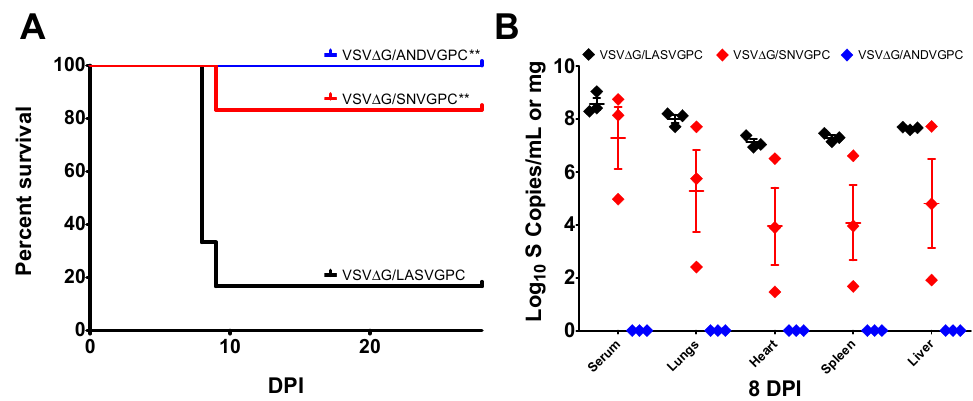
Figure 4. Protective e ffi cacy of rVSV ∆ G / ANDVGPC and rVSV ∆ G / SNVGPC against ANDV challenge ( A ) Survival of hamsters vaccinated with either rVSV ∆ G / ANDVGPC ( n = 6), rVSV ∆ G / SNVGPC ( n = 6), or control vaccine rVSV ∆ G / LASVGPC ( n = 6) following challenge with ANDV. ( B ) Presence, following ANDV challenge, of ANDV RNA in the serum and tissues in groups of vaccinated hamsters at 8 days post-infection (dpi) ( n = 3). Data means + SEM are shown. Statistical significance was determined via